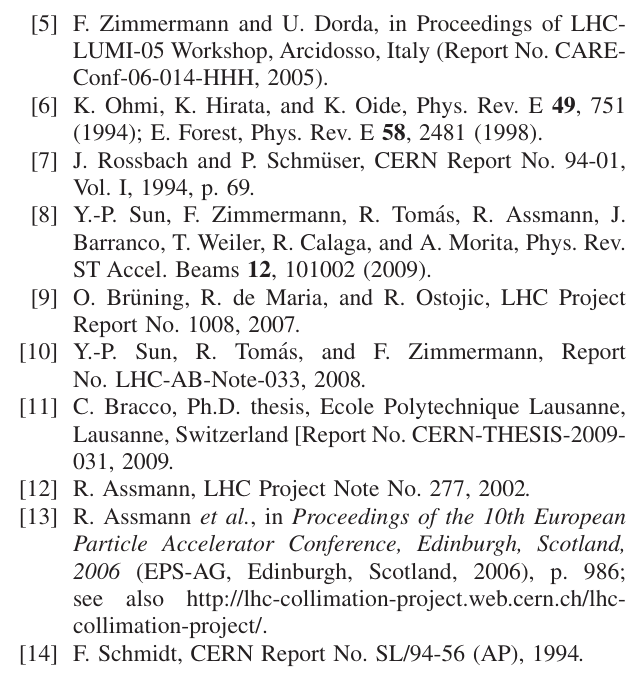
FIG. 16. (Color) Local cleaning inefficiency in LHC IR7, simulated with the 800-MHz global crab cavity (top energy, (cid:4) (cid:3) IP1 ; 5 ¼ z ¼ 2 (cid:7) z ¼ 3 (cid:7) 0 : 55 m ): beam halo with z ¼ 1 (cid:7) z (top left); beam halo with z (top right); beam halo with z (bottom left); beam halo with z ¼ 4 (cid:7) z (bottom